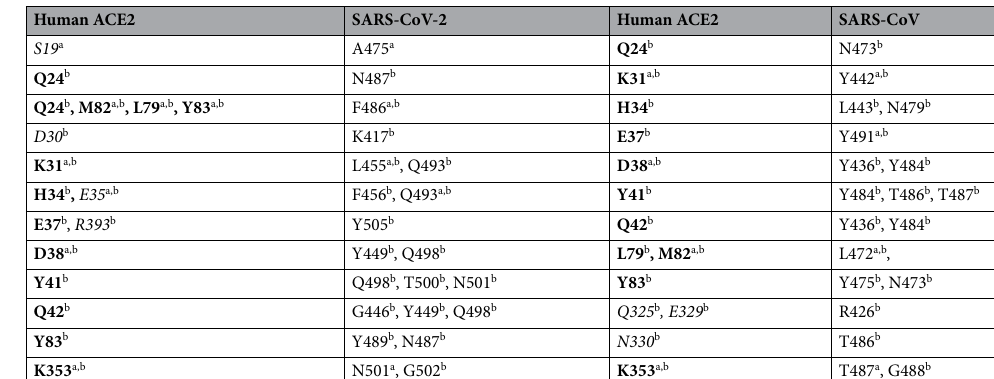
Table 1. Contacting sites at the interface of ACE2-S protein of SARS-CoV-2 (column 1, 2) and of SARS-CoV (column 3, 4). Data are retrieved from X-ray crystallography experiments by Shang et al. 5 and Lan et al. 2 . Each row specifies the site-specific contacts formed between human ACE2 and S protein (e.g., first row: ACE2 S19 binds SARS-CoV-2 S protein A475). In italics are key ACE2 sites that distinctly interact with SARS-CoV-2 or SARS-CoV S protein sites. In bold are ACE2 sites that interact with both SARS-CoV-2 and SARS-CoV S proteins at different ACE2-binding sites. The structural and chemical bond evidence for all listed interactions were described in Shang et al. 5 and Lan et al. 2 a Interacting residues retrieved from Shang et al. 5 b Interacting residues retrieved from Lan et al.